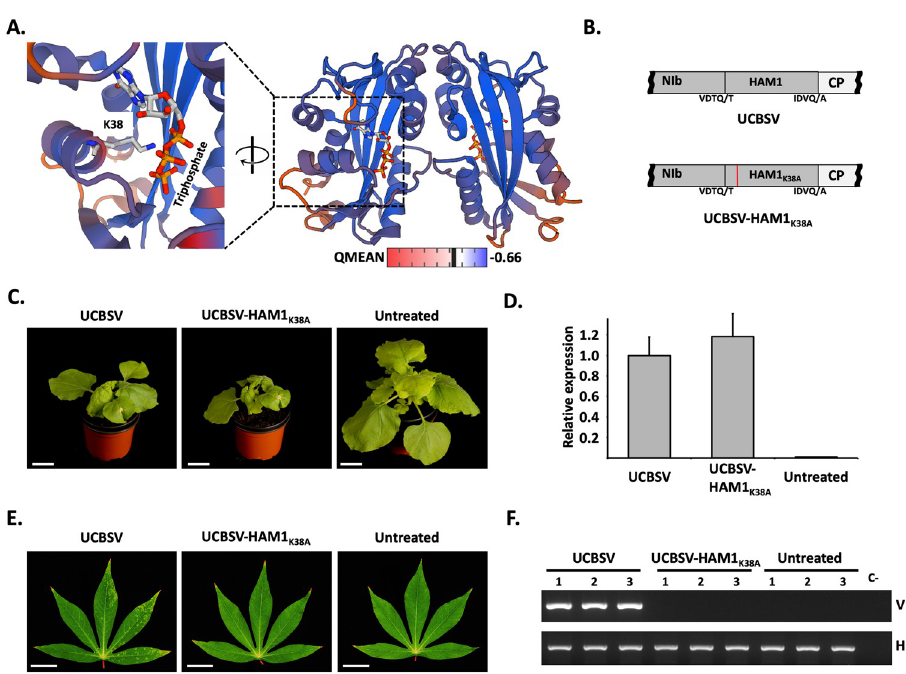
Fig 3. The pyrophosphatase activity of UCBSV HAM1 is required for the successful infection of cassava plants. (A) Model of the ITP-bound UCBSV HAM1 tridimensional structure. Interaction between K38 and ITP is highlighted at the left. (B) Schematic representation of the NIb-to-CP genomic segment of viruses used in these experiments. Amino acids around the NIaPro cleavage sites are depicted. The presence of the K38A mutation is indicated with a red line. (C) Representative pictures of infected and non-treated N . benthamiana plants taken at 11 days post-inoculation. White bar = 4 cm. (D) RT-qPCR measuring the accumulation of viral RNA in upper non-inoculated leaves of N . benthamiana plants infected with the indicated viruses. Each bar represents the average of three plants (error bar = 1 standard deviation). For normalization, the average of wild type UCBSV is equal to 1. (E) Representative pictures of upper non-inoculated leaves, taken at 60 days post-inoculation, of cassava plants inoculated with the indicated viruses. White bar = 4 cm. (F) Analysis by agarose gel electrophoresis of a fragment of the UCBSV genome (V) and of a plant housekeeping gene (H) amplified by RT-PCR. RNA samples from upper non-inoculated leaves of 3 independent cassava plants inoculated with the indicated viruses were used as template.